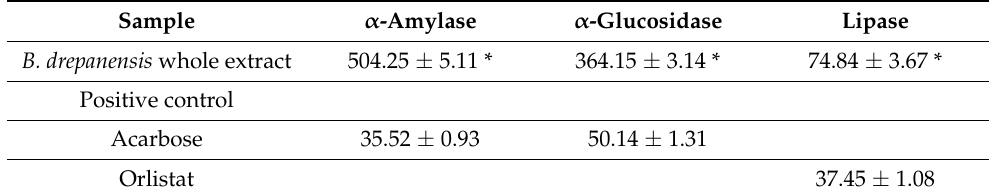
Table 2. Hypoglycaemic and hypolipidemic activity (IC 50 value, µ g/mL) of B. drepanensis . Sample α